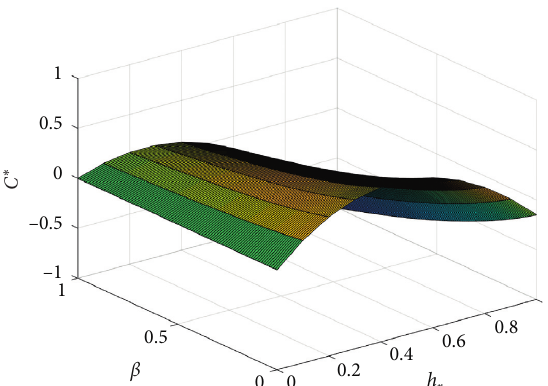
Figure 17: Effect of risk level β and unit inventory cost h water supply